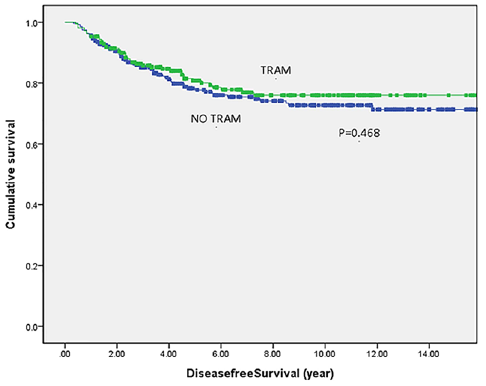
Fig 1. Disease free survival in 492 breast cancer patients. Kaplan-Meier curves demonstrate disease free survival in 492 study patients. Green line denotes TRAM flap group (n = 213) while blue line represents patients with no reconstruction (n = 279). Abbreviation: TRAM: transverse rectus abdominis